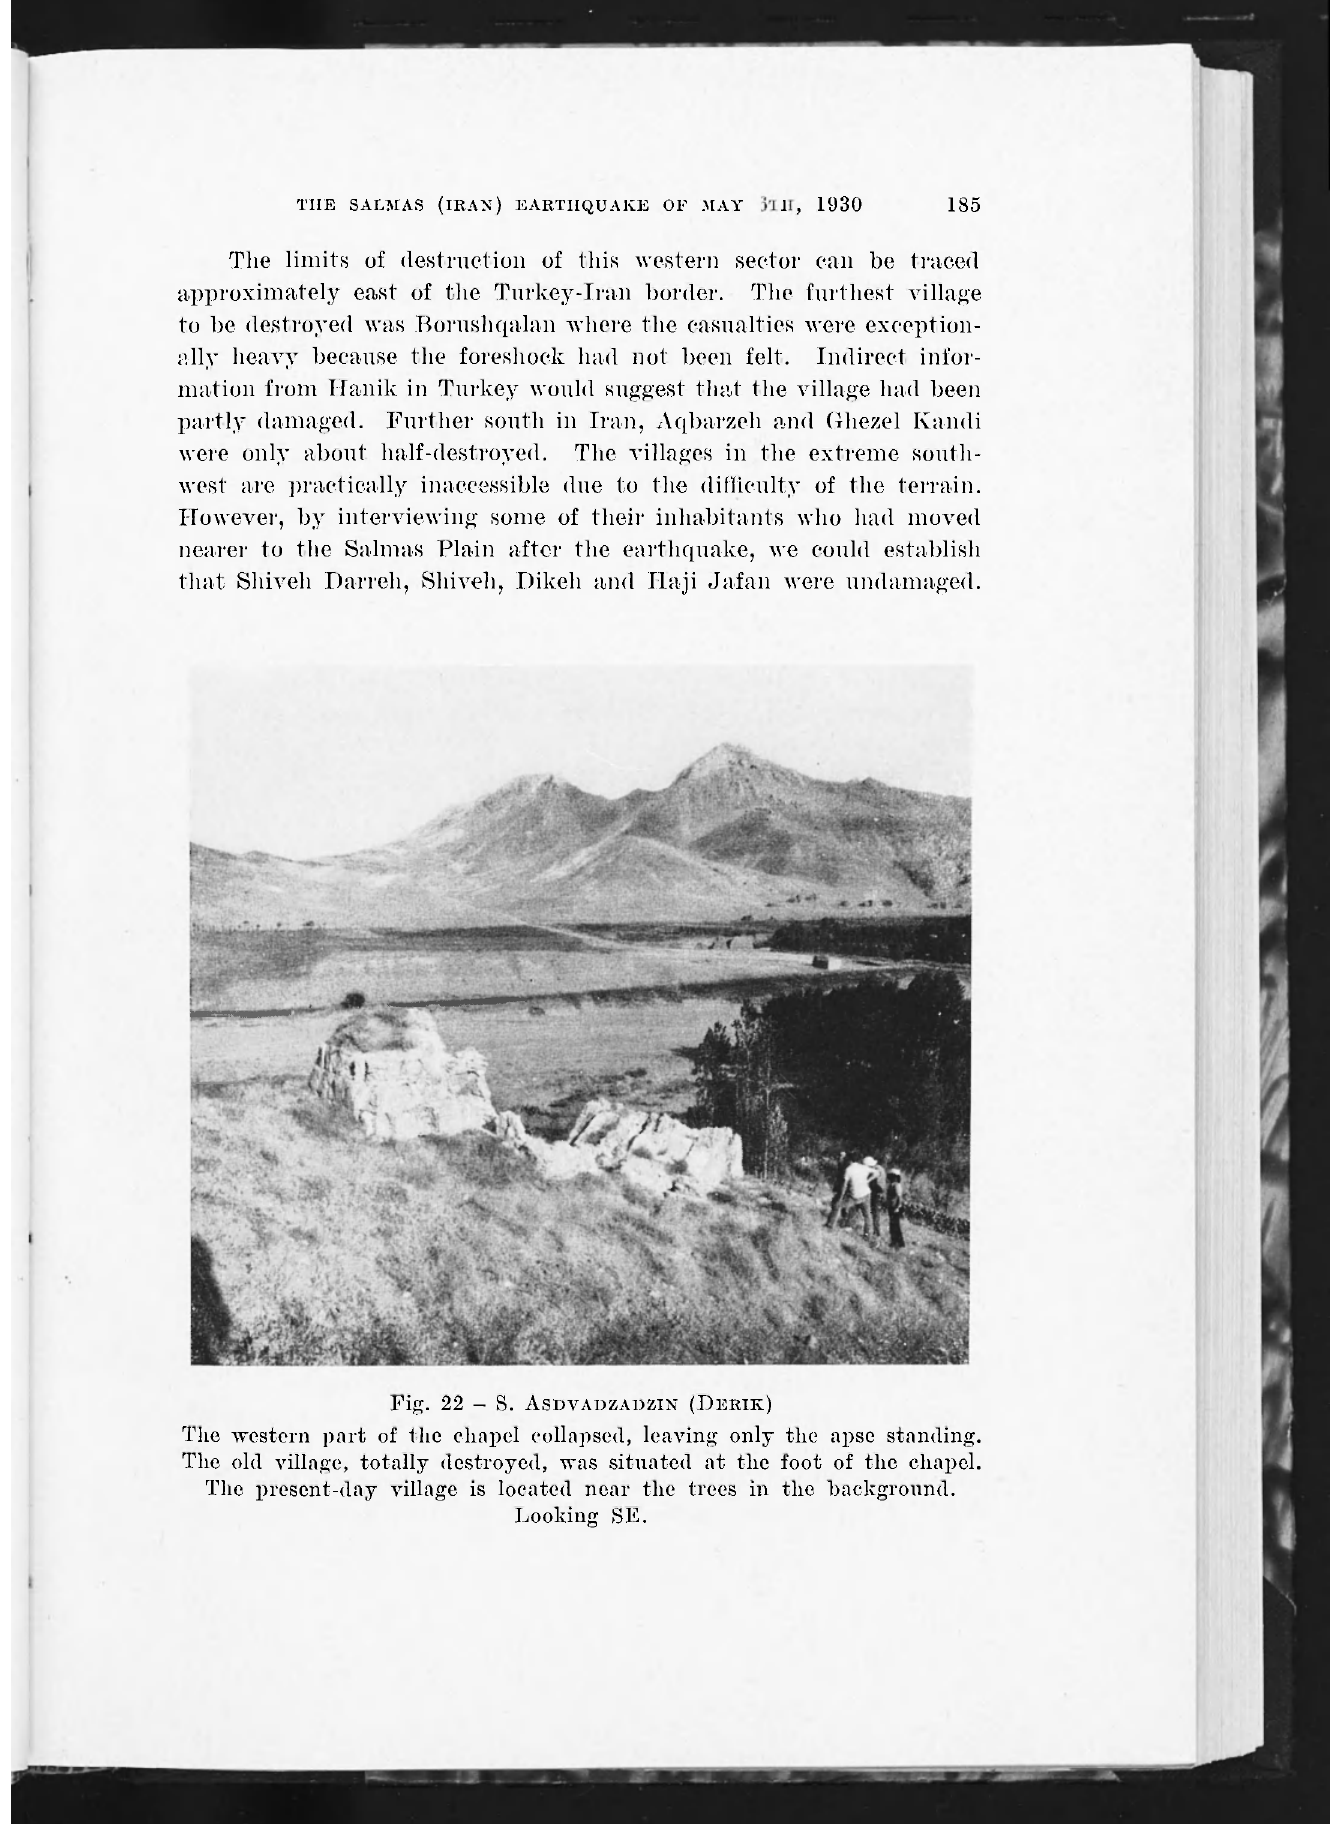
Fig. 22 - S. ASDVADZADZIN